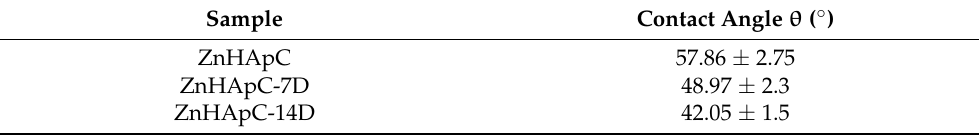
Table 1. Water contact angle on ZnHApC composite coatings surfaces.